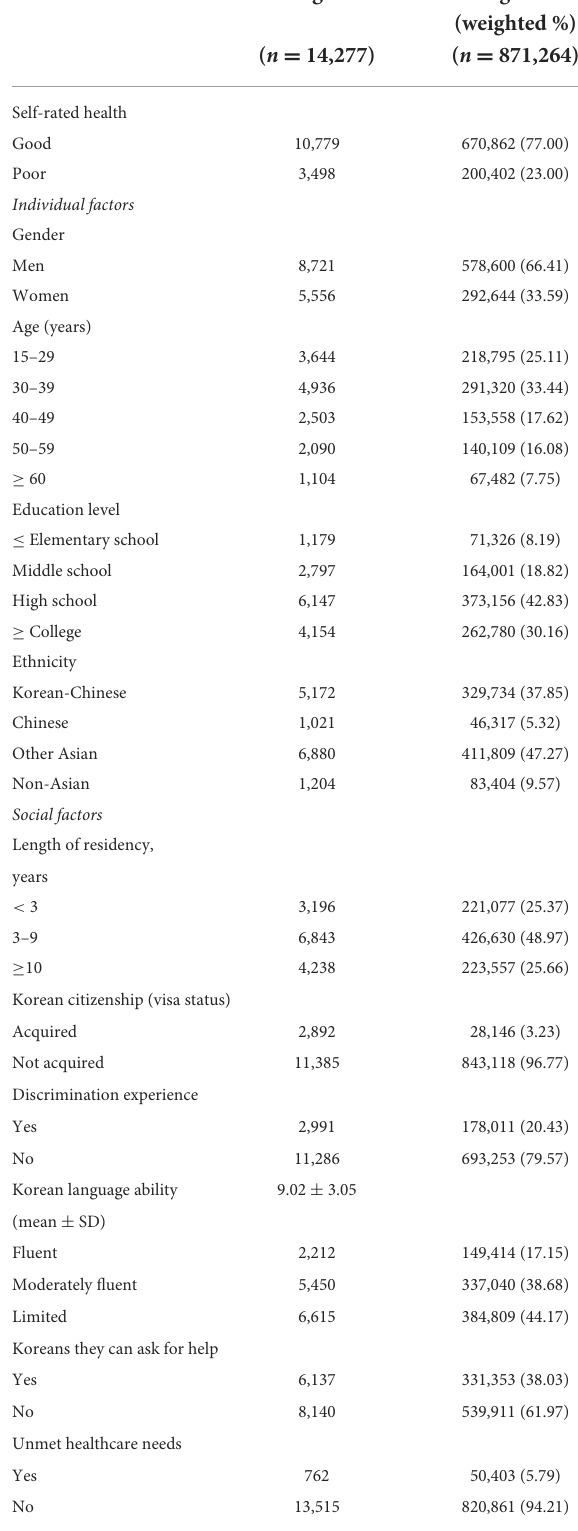
TABLE 1 Baseline characteristics of the study